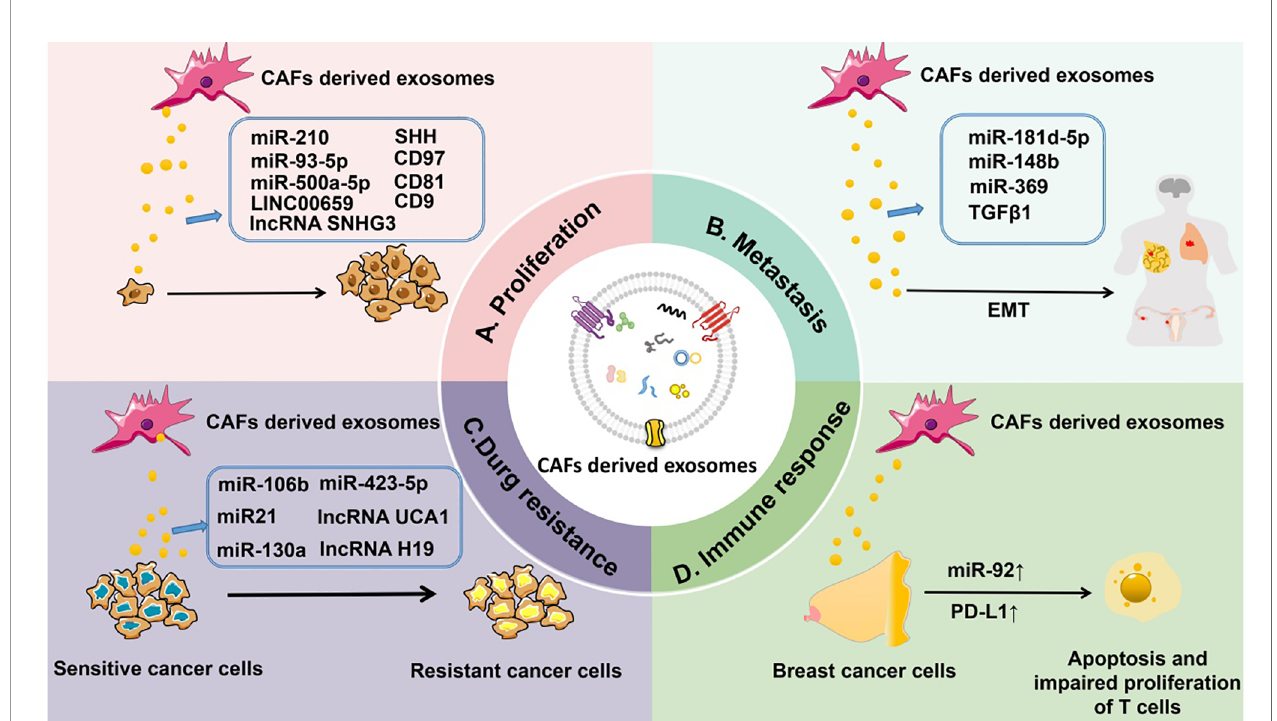
FIGURE 3 | CAF-derived exosomes can regulate tumorigenesis. (A) CAF-derived exosomal ncRNAs (such as miR-210, miR-93-5p, miR-500a-5p, and lncRNAs LINC00659 and SNHG3) or proteins (such as SHH, CD97, CD81, and CD9) affect the proliferation of tumors. (B) CAF-derived exosomal ncRNAs (such as miR- 181d-5p, miR-148b, and miR-369) or proteins (TGF- b ) control the metastasis of tumors. (C) CAF-derived exosomal ncRNAs (such as miR-106b, miR-423-5p, miR- 21, miR-130a, and lncRNAs UCA1 and H19) or proteins (TGF- b ) in fl uence drug resistance of tumors. (D) CAF-derived exosomal miR-92 and PD-L1 regulate the immune response to tumors by inducing apoptosis and impairing proliferation of T